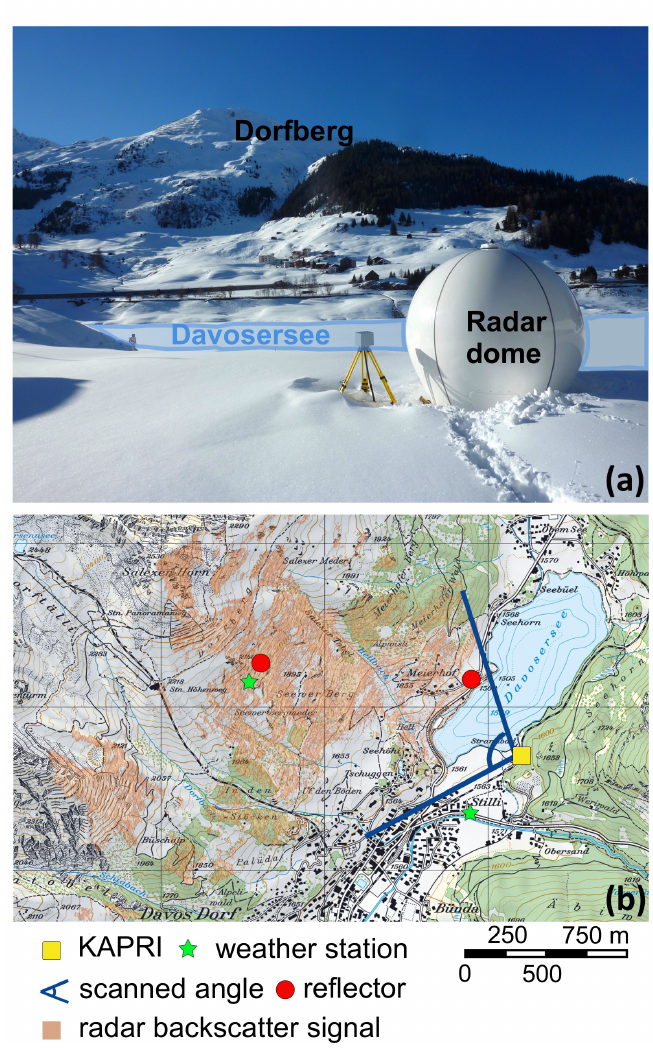
Figure 2. Davos test site. ( a ) the photograph shows the radar (inside a radome for weather protection), the reflective lake (Davosersee) and the observation area (Dorfberg); ( b ) map of the test site showing radar location and coverage, location of reflectors and the weather